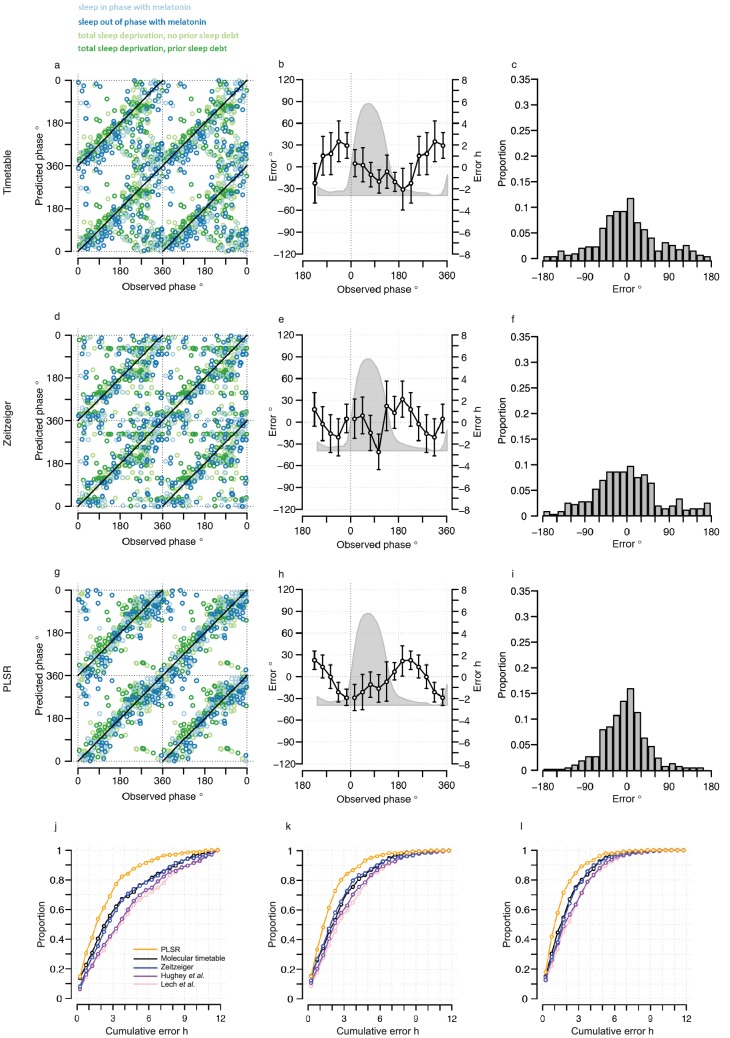
Performance of one-sample models derived from the training set when used to predict circadian phase in the validation set.(a, d and g) Predicted circadian phase of a blood sample vs. the observed melatonin phase for each sample in the validation set for the one-sample molecular timetable model (a), the one-sample Zeitzeiger model (d) and the one-sample PLSR-based model (g). Circadian phase 0 corresponds to the onset of the melatonin rhythm, which across conditions occurred on average at 23:30 ± 15 min (across all conditions and the training and validation data sets). Please note that the data are double-plotted. The line of unity represents perfect prediction. (b, e and h) Average (mean) error and 95% confidence intervals of the mean error per 30o, that is 120 min, for each 30° circadian phase bins across the circadian cycle, for each of the models. The grey area plot represents the average melatonin profile. Panels (c, f and i) frequency distribution of errors. Errors were sorted into 15o, that is, 60 min bins for each model. For each of the models, the mode of the distribution is near 0, but the width of the distribution varies across models. (j) Proportion of predictions based on one sample vs. cumulative error as a measure of overall performance. (k) Proportion of predictions based on two consecutive samples vs. cumulative two sample average error as a measure of overall performance. (l) Proportion of predictions based on three consecutive samples vs. cumulative three sample average error as a measure of overall performance. Data source file Figure 3—source data 1.DOI:
http://dx.doi.org/10.7554/eLife.20214.00910.7554/eLife.20214.010Figure 3—source data 1.Source data file for generating panels in Figure 3.